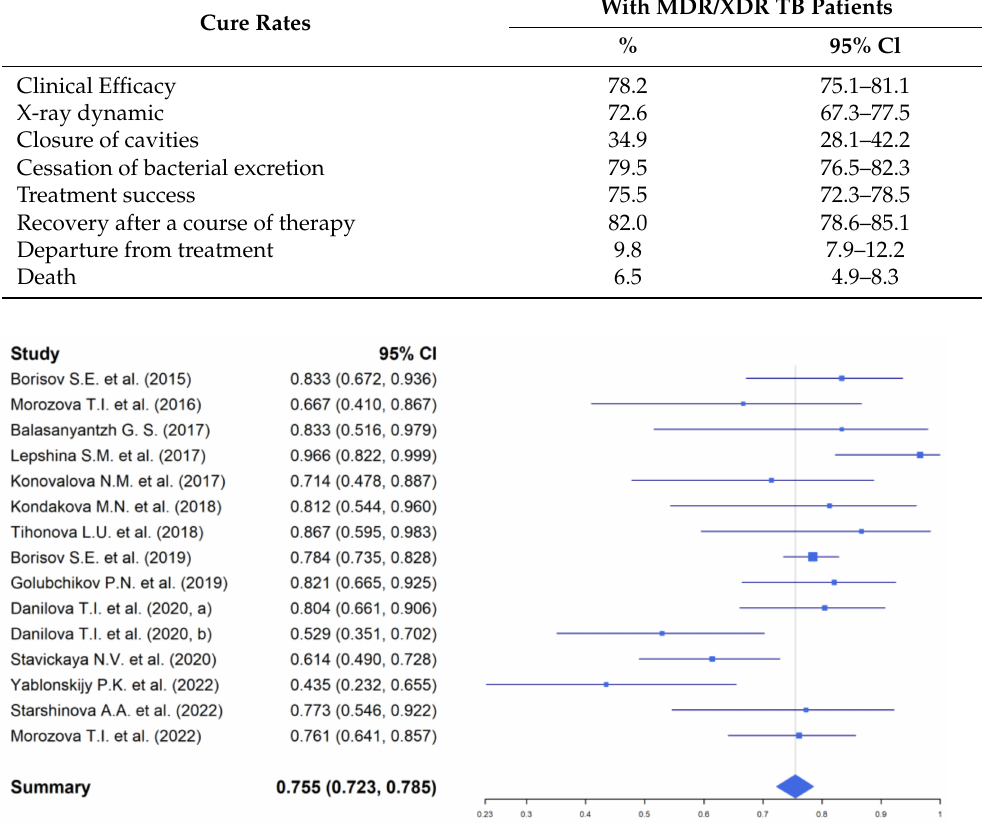
Figure 4. The efficacy of the TB treatment with the use of bedaquiline by the end of 24–26 weeks of therapy. Borisov et al. [22], Morozova et al. [23], Balasanyantzh [24], Lepshina et al. [26], Konoval- ova et al. [27], Kondakova et al. [28], Tihonova et al. [29], Borisov et al. [30], Golubchikov et al.